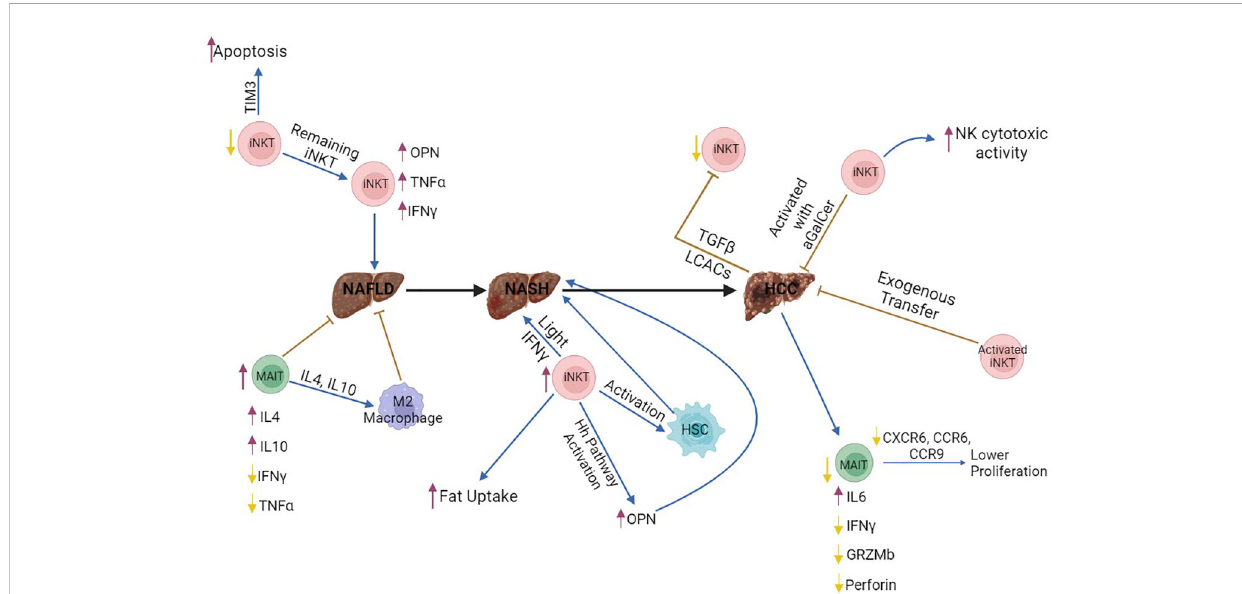
FIGURE 3 The role of MAIT and iNKT cells in NAFLD, NASH and HCC. Invariant NKT (iNKT) cells produce increased amounts of fi brogenic factors, such as OPN, and pro-in fl ammatory cytokines, including IFN g and TNF a , thus enhancing liver damage and NAFLD onset. In addition, iNKT cells promote NASH development through enhanced fat uptake by hepatocytes, activation of hepatic stellate cells, and production of Light, which enhances activation of CD8 + T cells. In contrast, activation of iNKT cells with aGalCer or exogenous transfer of iNKT cells suppresses HCC development and enhances the function of NK cells. However, HCC cells may suppress this anti-oncogenic function of iNKT cells through production of TGF b and long-chain acylcarnitines, which are directly recognized by iNKT cells, thus leading to impaired secretion of IFN g and TNF a . Therefore, iNKT cells may promote initiation of liver tumorigenesis through NAFLD and NASH development, while they may be able to fi ght established tumors. MAIT cells contribute to the resolution of NAFLD through IL4 and IL10 production, which drive M2 polarization in macrophages. However, MAIT cell number is lower in HCC,